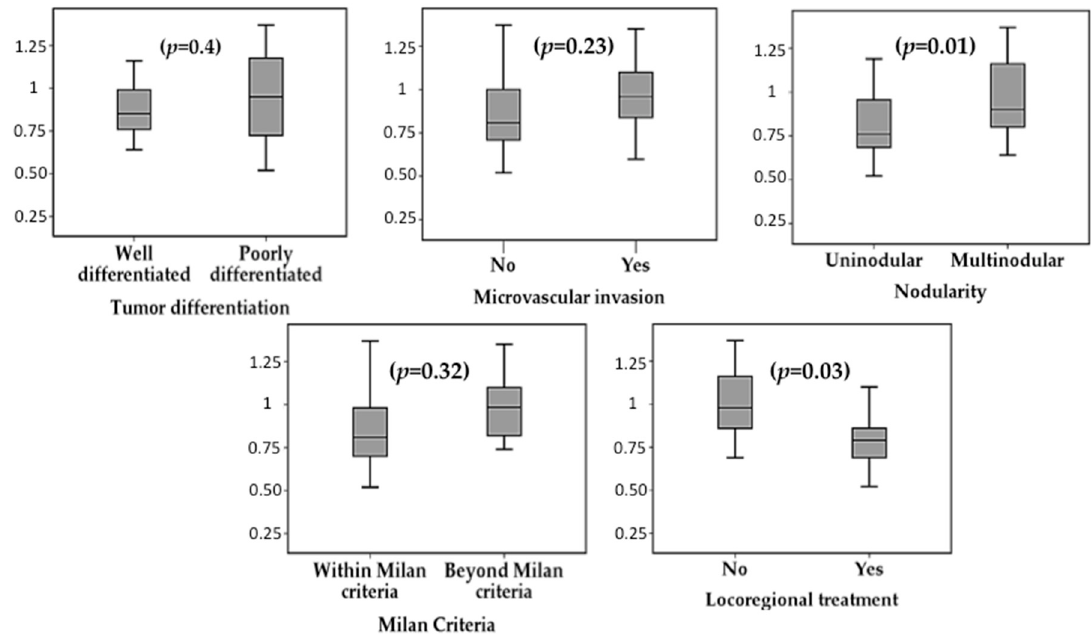
Figure 1. Phospho-mTOR expression in tumoral tissue (I/mm 2 ) according to histological features of hepatocellular carcinoma as determined in the explanted liver: histological tumour differentiation, microvascular invasion, tumour nodularity, fulfilment of Milan criteria and prior locoregional ablative therapy.